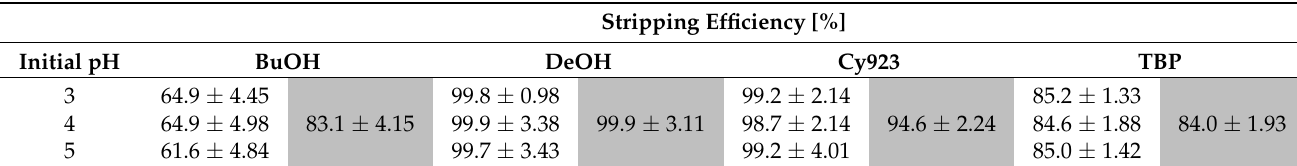
Table 3. Stripping efficiencies of vanillin and catechol using different organic phases (the colored efficiencies correspond to